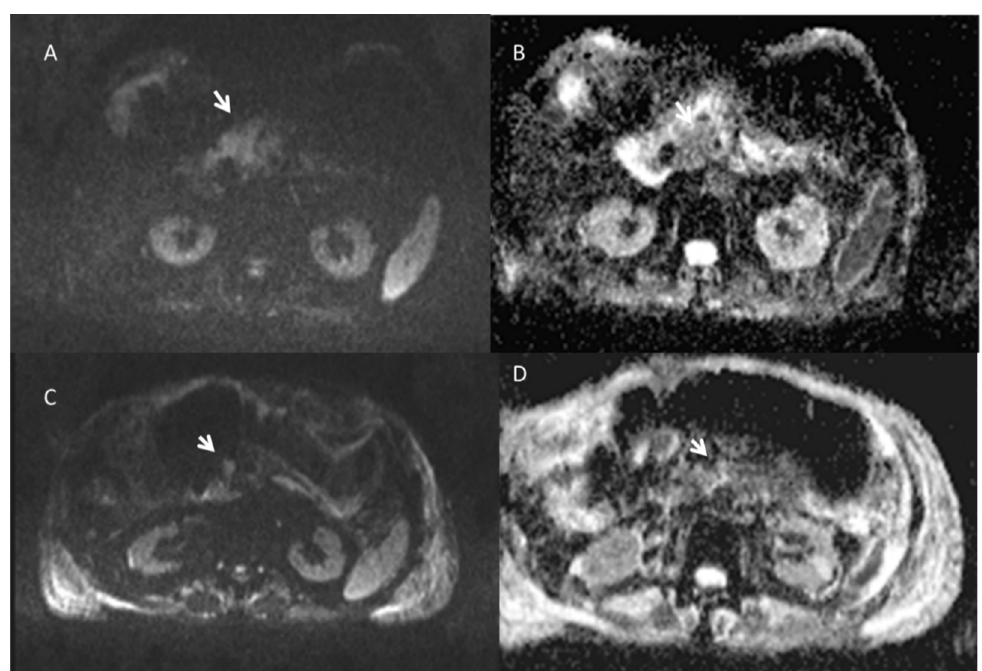
Figure 5. Pancreatic cancer treated with ECT. Pre-treatment, the lesion shows restricted diffusion on b800 s/mm 2 ( A ) and hypointense SI in ADC map ( B ). After treatment, only vital tumor (arrow) shows restricted diffusion on b800 s/mm 2 ( C ) and hypointense SI in ADC map ( D ).